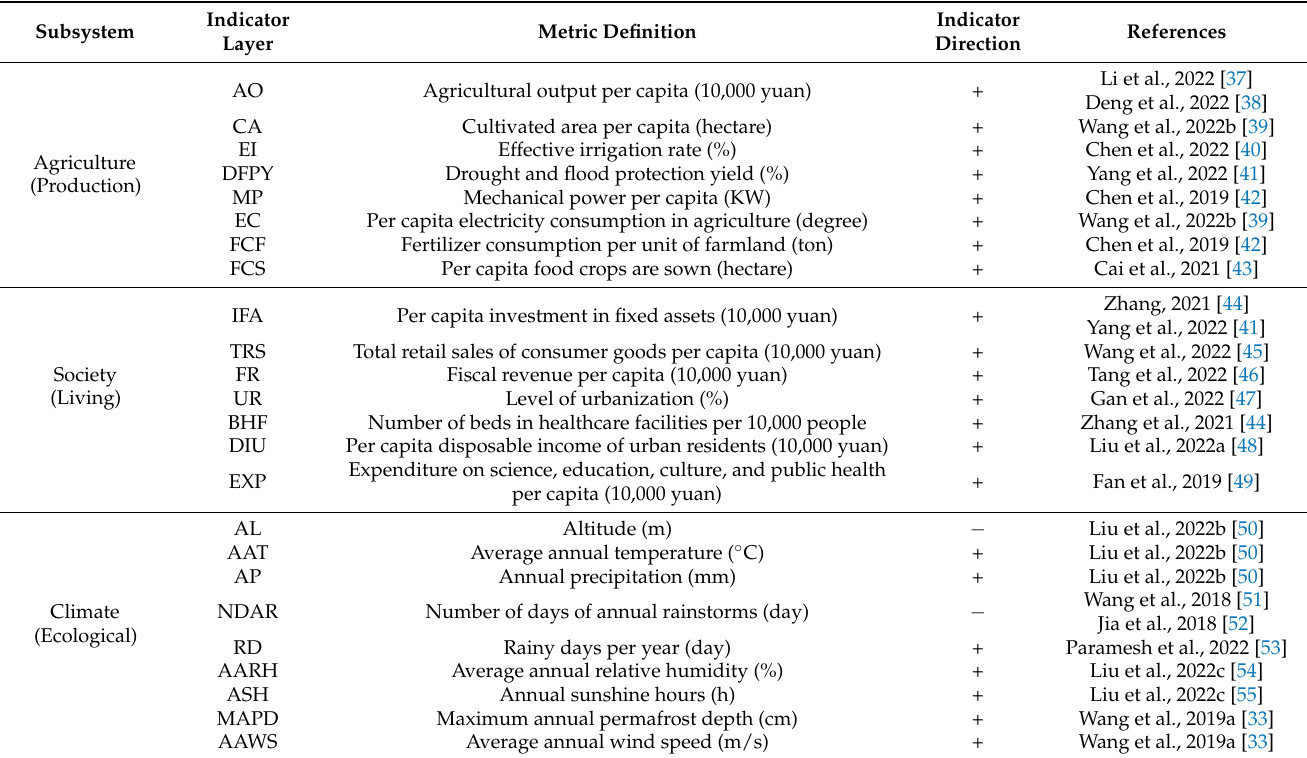
Table 1. Coupling coordinated evaluation index system for APLE